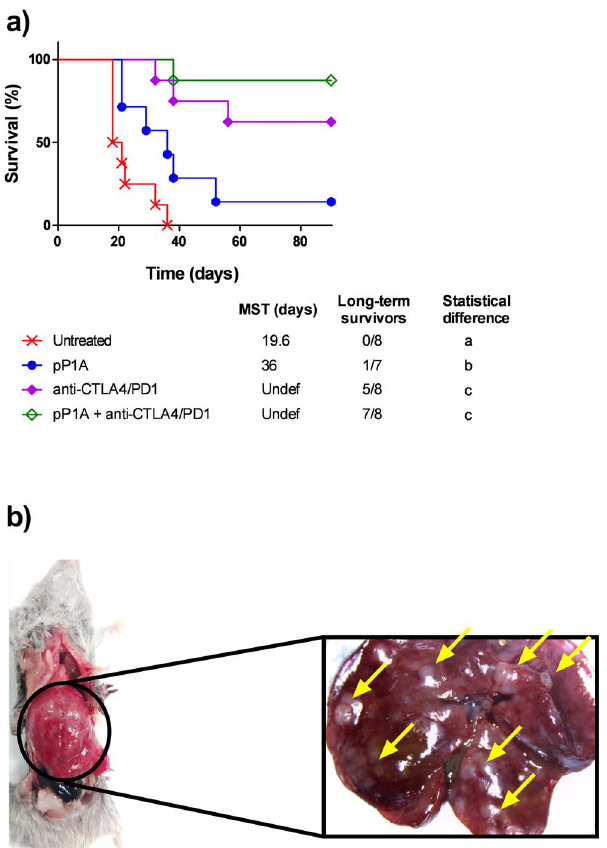
Figure 4. Mouse follow-up after tumor removal at day 10 post-P815 injection. ( a ) Survival curve representing the percentage of living mice (%) as a function of time (days). MST = median survival time. Statistical analysis using log-rank (Mantel-Cox) test to compare each group to the others. Data with no common letters in the statistical analysis ( a – c ) are significantly different (p < 0.05, n = 8). ( b ) Representative image of mouse postmortem analysis with magnification of liver